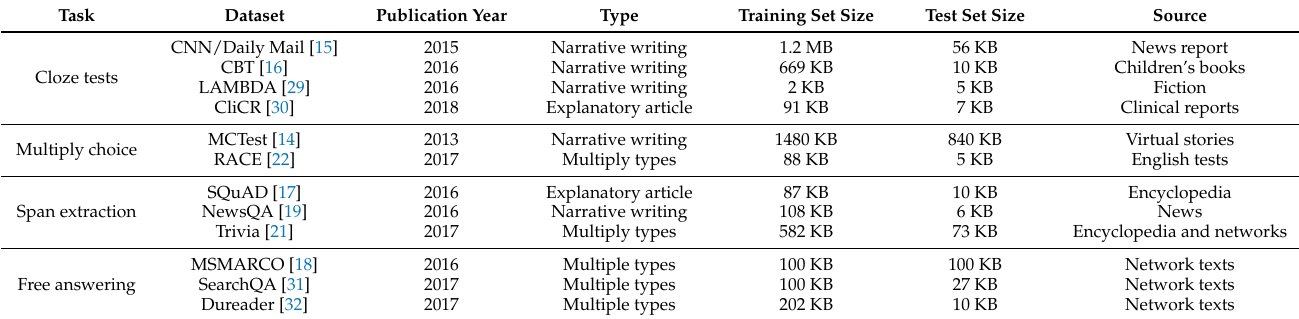
Table 1. Public datasets for machine reading comprehension.